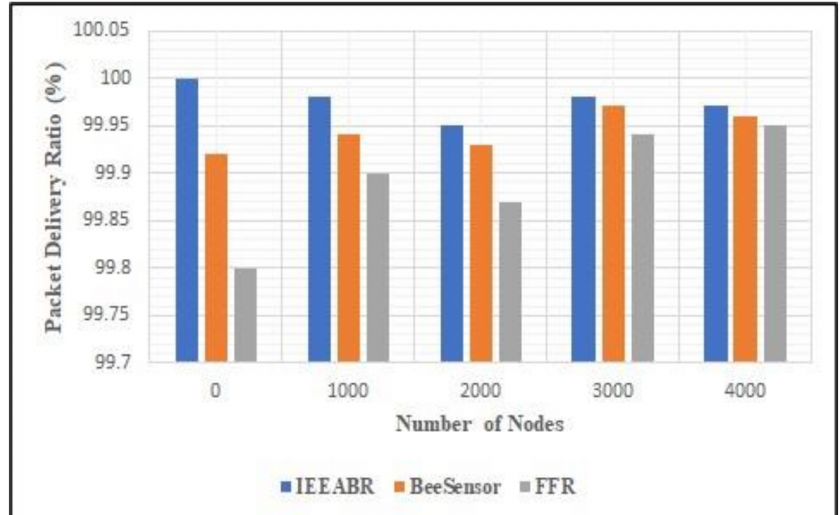
Figure 11. Packet delivery